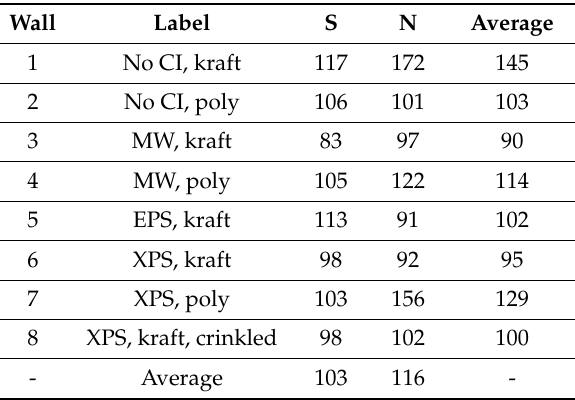
Table 3. Total scaled error for model of each wall assembly.